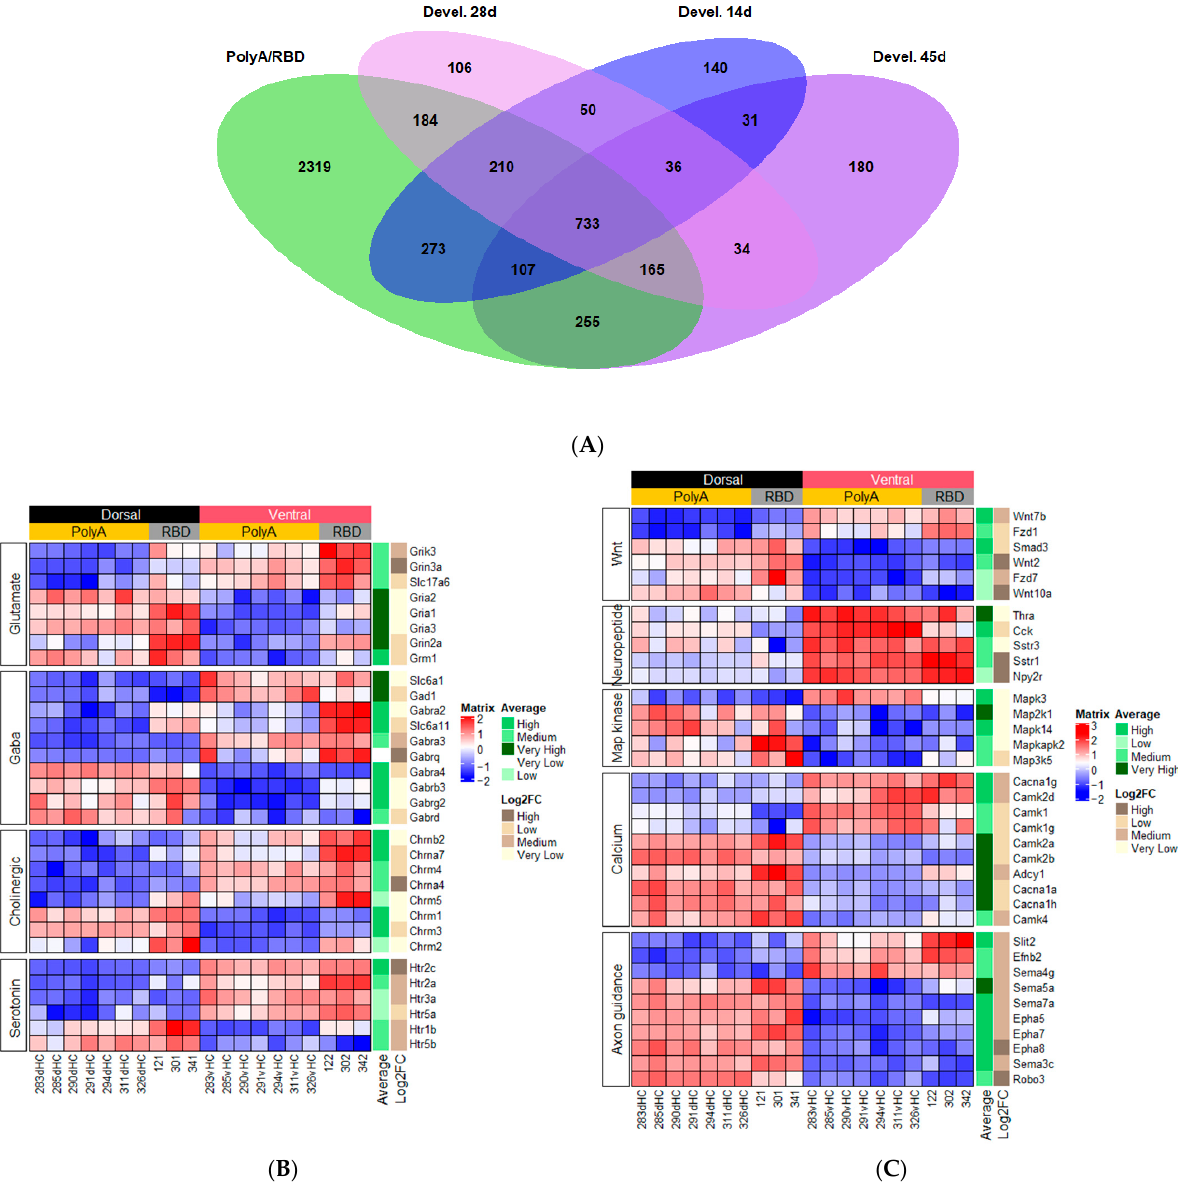
Figure 5. ( A ) Intersection between genes differentially expressed (VH vs. DH) in polyA/RBD conserved gene set (4275) and hippocampal development dataset from [14]. ( B , C ) Heatmaps for genes from intersection between our dataset and datasets for P45 from [14].